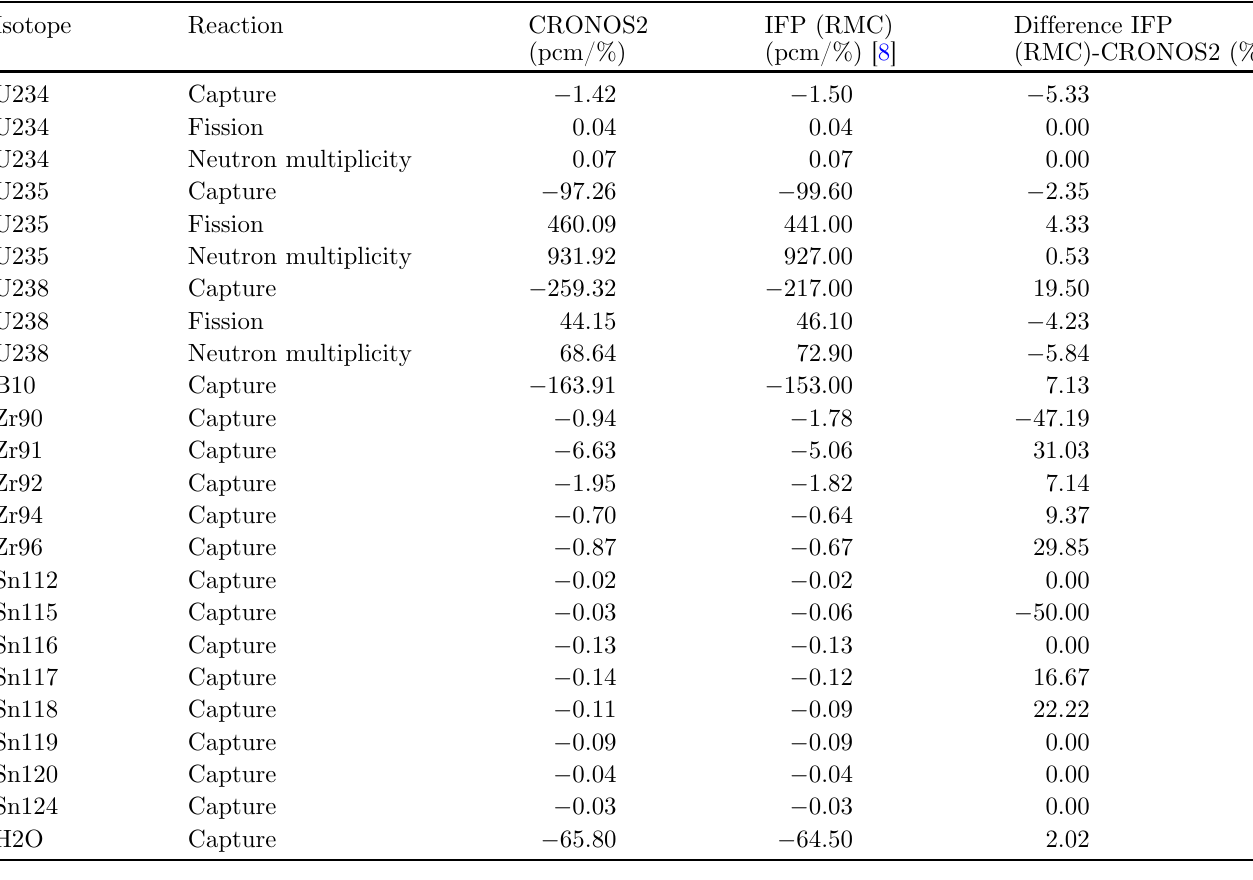
Table 1. CRONOS2 sensitivities compared to IFP sensitivities coming from RMC code [8]. Isotope Reaction